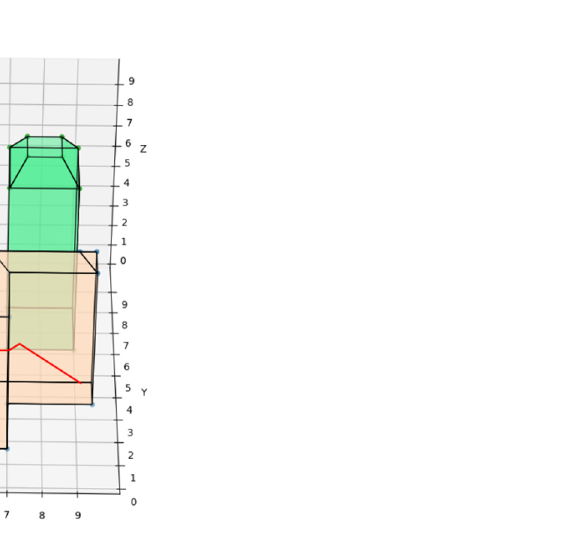
Figure 13. UAV route deploying traditional artificial potential field route planning algorithms in disturbance scenarios.